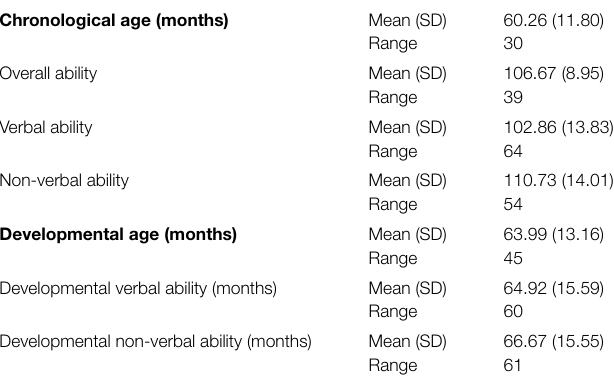
TABLE 2 | Participants general and age-equivalent cognitive abilities